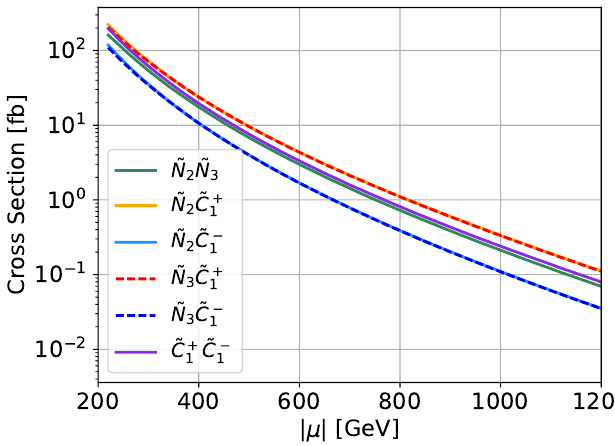
Figure 4 . The production cross section of higgsino-like neutralino/chargino at the 14 TeV LHC with M 1 = 100 GeV and M 2 = 3